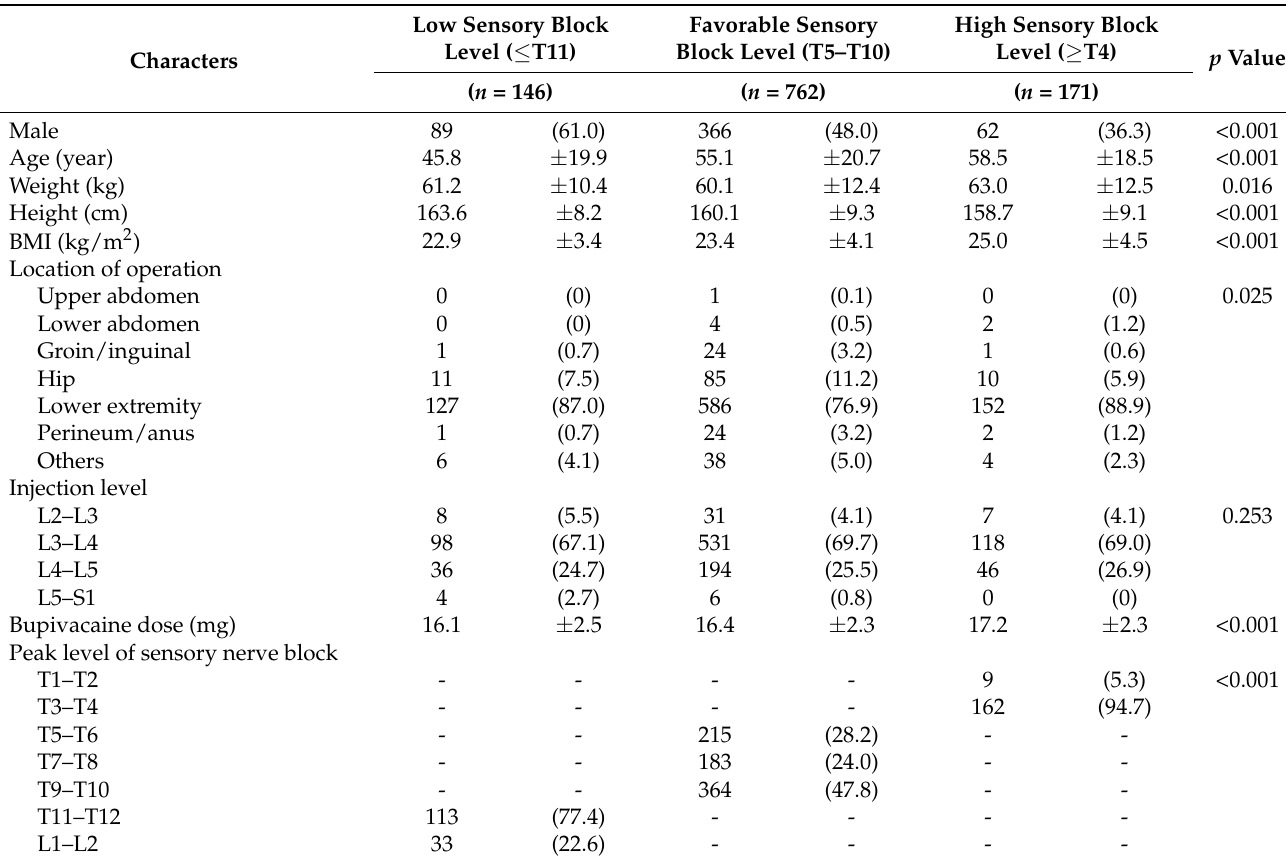
Table 1. Overall clinical characteristics of the study patients by sensory block levels.